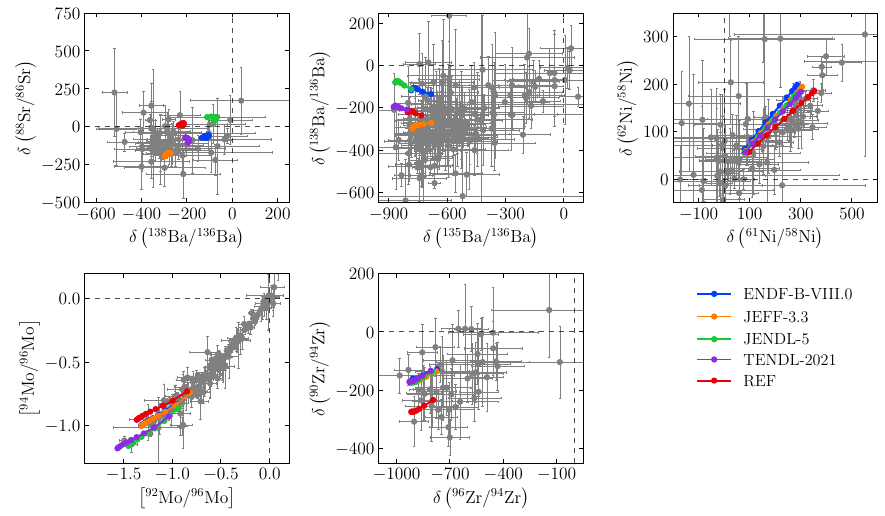
Figure 3. Comparison between AGB model calculations [23, 24] using di ff erent nuclear data input and isotopic abundances in presolar grains. The results obtained with data from KADoNiS 0.3, taken as a reference (REF), are shown in red. Grain data are from the PGD database